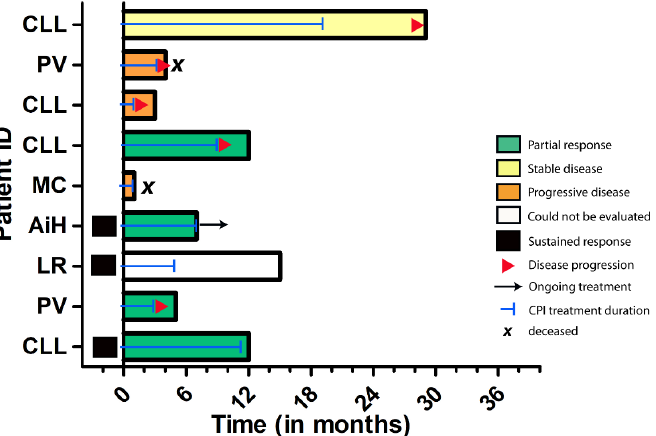
Figure 5. Swimmer’s plot depicting the individual outcomes of immunocompromised patients in this study. Among those patients receiving first-line CPI treatment, three patients showed sustained tumor responses, whereas the majority of patients experienced tumor progression in the course of the disease. Abbreviations: CLL = chronic lymphocytic leukaemia, PV = polycythemia vera; MC = Crohn´s disease, AiH = autoimmune hepatitis, LR = lichen planus mucosae. Thirteen patients discontinued CPI therapy during ongoing remission (7 PR, 6 CR, or no evidence of disease, NED) at a median of 9 months. Reasons for treatment cessation included CPI-associated toxicities (pneumonitis, grade 2; hepatitis, grade 3; fatigue), the explicit wish of the patient, or cessation-sustained tumor remission. Within the subsequent 22-month follow-up-period, three patients relapsed. Notably, among all patients who discontinued CPI in ongoing remission, three patients had an immunosuppressive condition and 2 of them relapsed shortly after treatment cessation (median: 1.5 months). Among these patients, one patient with concomitant B-CLL was re- challenged with cemiplimab after relapse of the primary tumor in the genital area and achieved stable disease thereafter. Overall, 10 patients received subsequent treatments upon disease progression after initial CPI treatment. Among these patients, 7 were re-challenged with CPI (1 CR; 2 PR; 3 SD; 1 not assessed, due to early discontinuation for severe AE), 1 was treated with taxol- based chemotherapy (SD), 1 received EGFR-inhibitor cetuximab (PR), and 1 patient received a combination of cemiplimab and cetuximab (not assessed at data cut-off). 3.6. Treatment-Related Adverse Events during CPI Therapy Among the entire cohort, seven patients developed AE of CTCAE grade III or higher (17.9%), which included hepatitis (n = 2), colitis (n = 2), pancytopenia (n = 1), fatigue (n = 1), anaphylactic shock (n = 1), and pancreatitis (n = 1). Thereof, three patients permanently discontinued CPI therapy. Serious AE were more frequent among immunocompromised patients, although this association was below statistical significance ( p = 0.319, Table 1). Among patients with serious AE, six achieved at least stable disease upon CPI therapy with three of these showing an ongoing tumor remission. Other documented side-effects